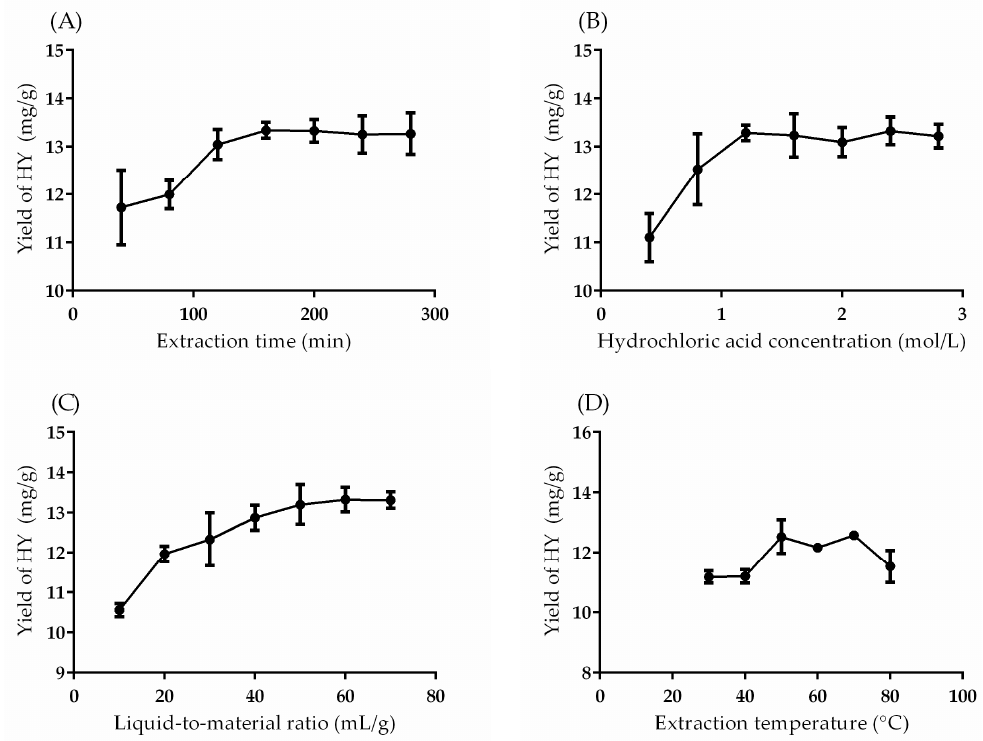
Figure 1. The effects of four single factors on the yield of HT. ( A ) Extraction time, ( B ) hydrochloric acid concentration, ( C ) liquid-to-material ratio and ( D ) extraction temperature.